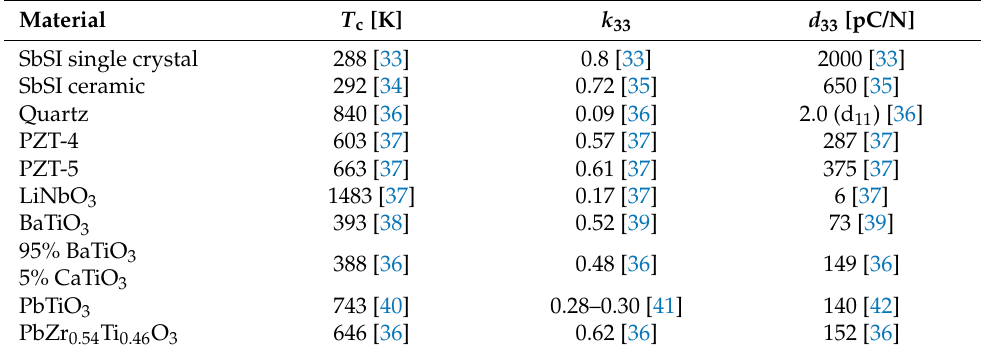
Table 1. A comparison of the functional properties of a few selected piezoelectric materials, including SbSI single crystal and its ceramic